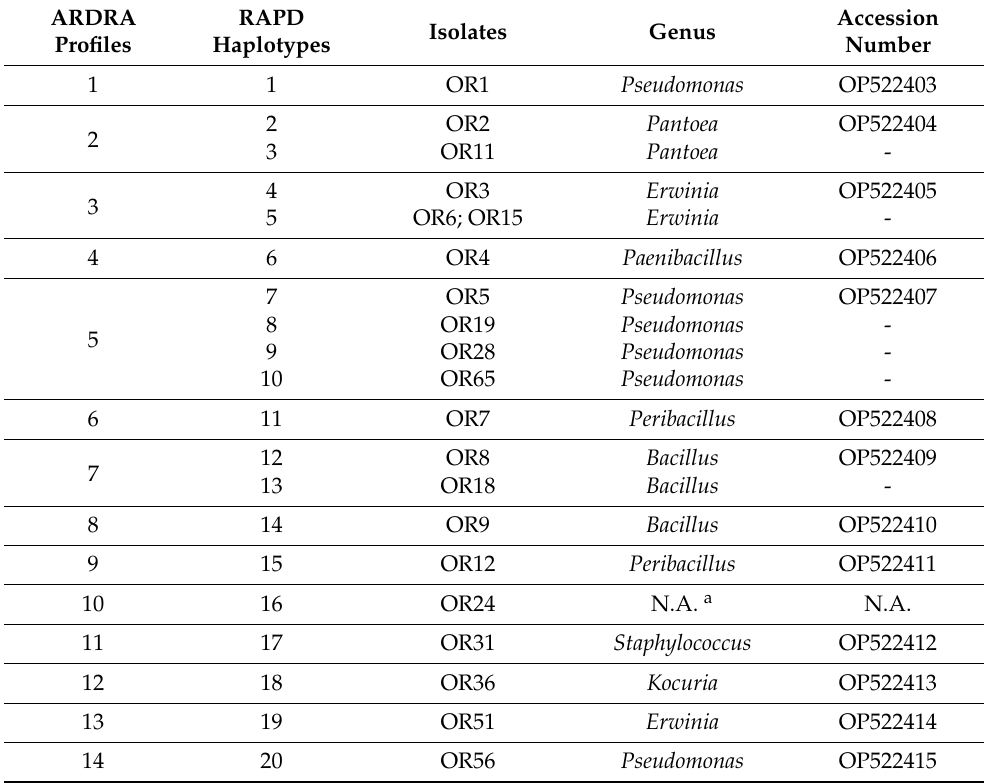
Table 2. Bacterial strains isolated from O. heracleoticum